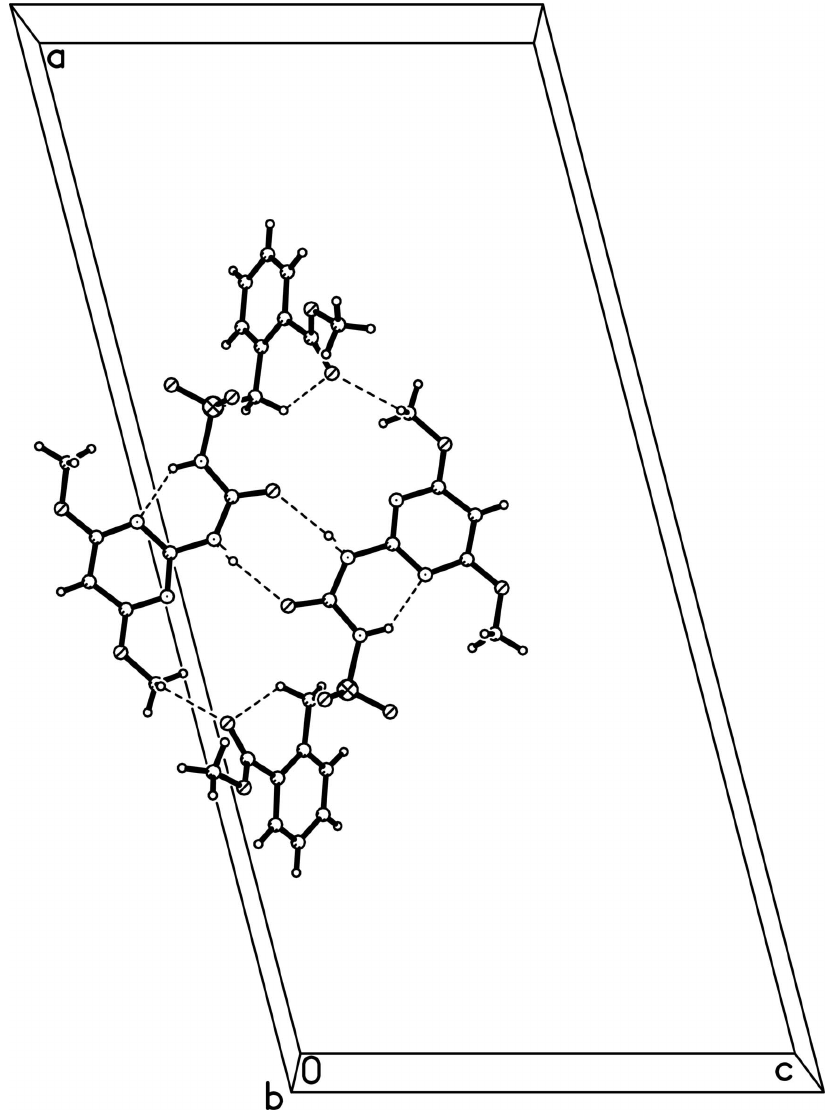
Figure 2 A hydrogen-bonded dimer. Dashed lines indicate hydrogen